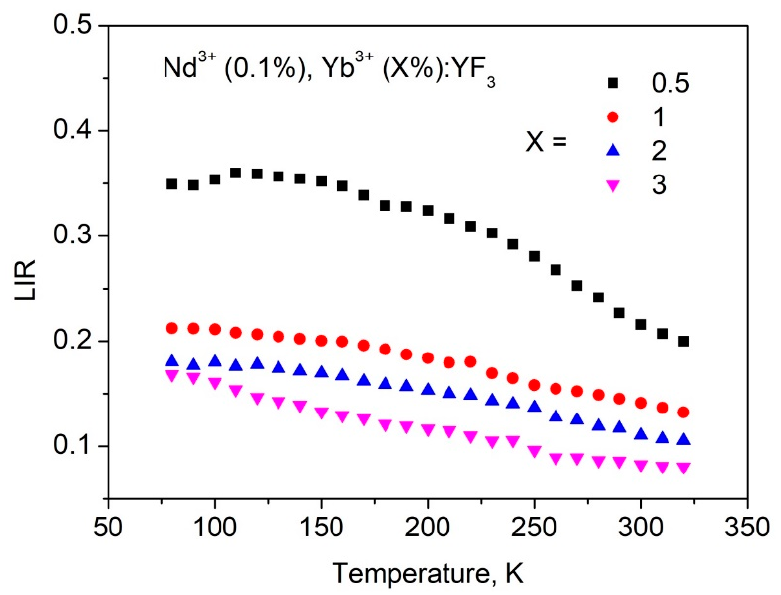
Figure 6. LIR as a function of temperature.